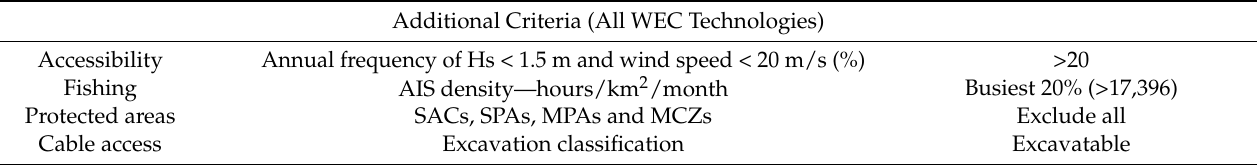
Table 9. Details of additional site selection inputs for identification of optimum wave energy